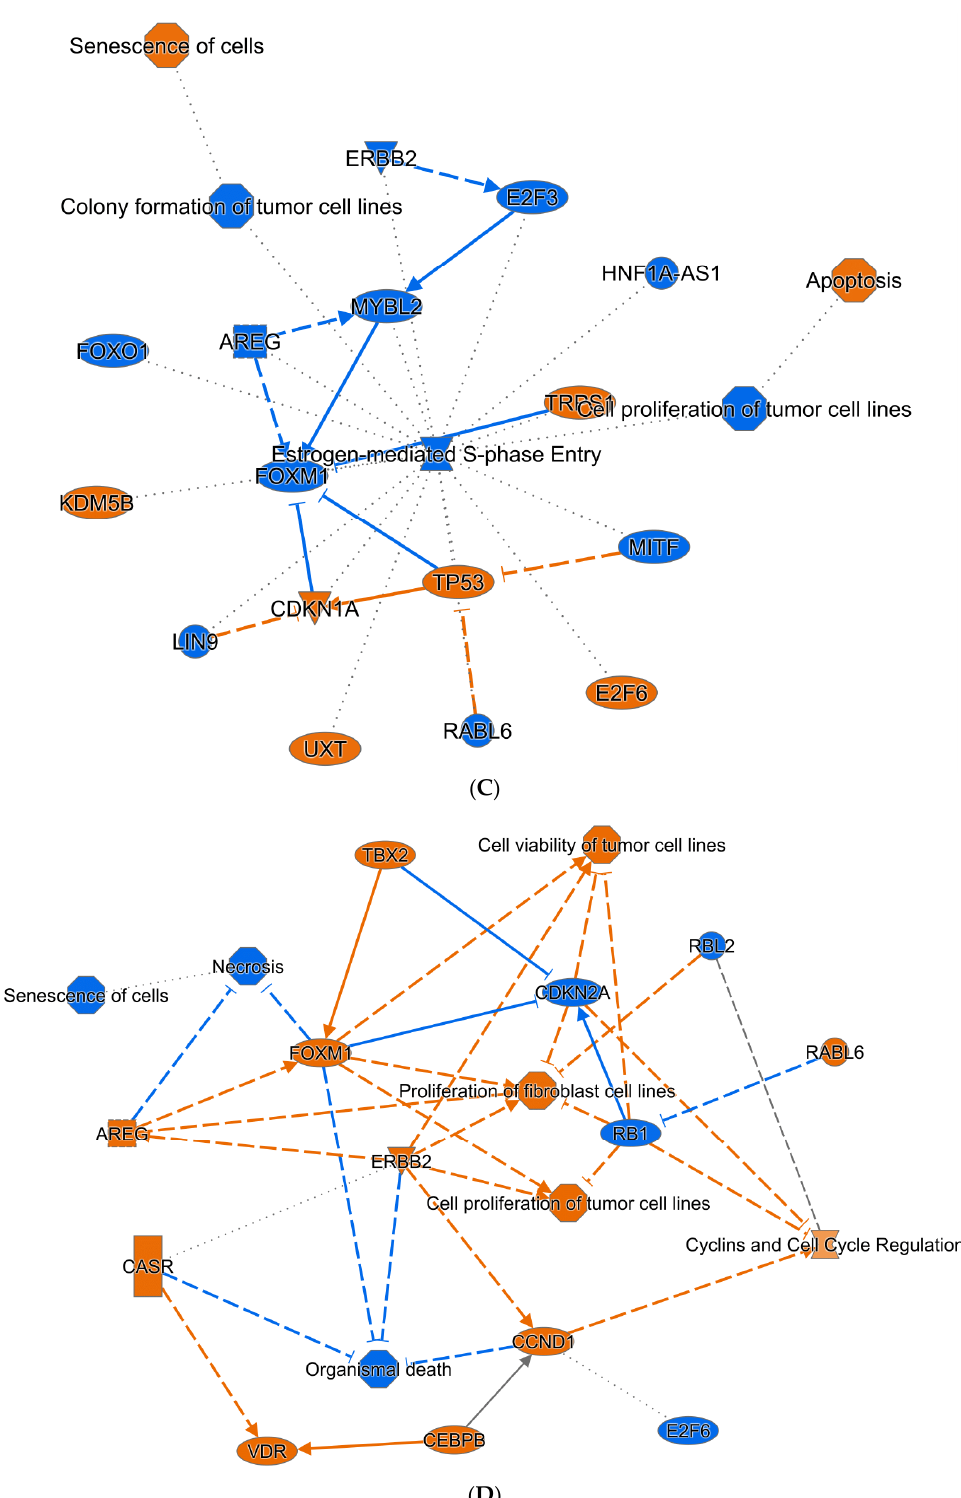
Figure 4. Ingenuity Pathway Analysis (IPA) prediction of the molecular and cellular functions of ZNF582-AS1 based on its expression and methylation signatures. ( A ) IPA prediction of the molecular and cellular functions related to the ZNF582-AS1 expression signature. ( B ) IPA prediction of the molecular and cellular functions related to the ZNF582-AS1 promoter methylation signature. ( C ) IPA prediction of the signal network related to the ZNF582-AS1 expression signature. ( D ) IPA prediction of the signal network related to the ZNF582-AS1 promoter methylation